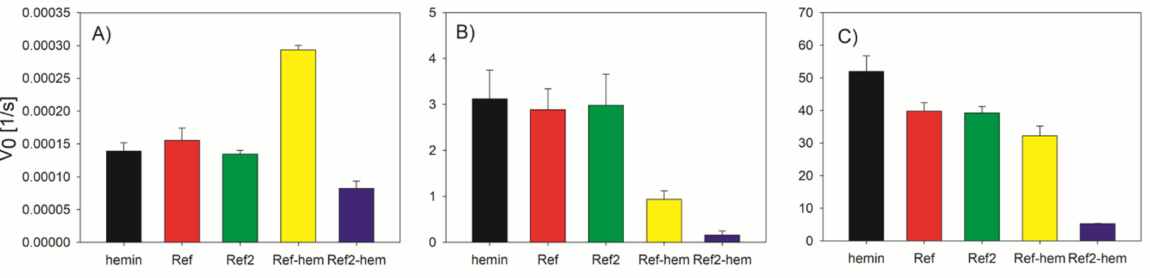
Figure 3. Initial velocity of substrates oxidation by reference oligonucleotides Ref and Ref2 in complex with hemin and DNA-hemin conjugates in comparison to hemin: ( A ) ABTS, ( B ) MNBDH, and ( C ) Amplex